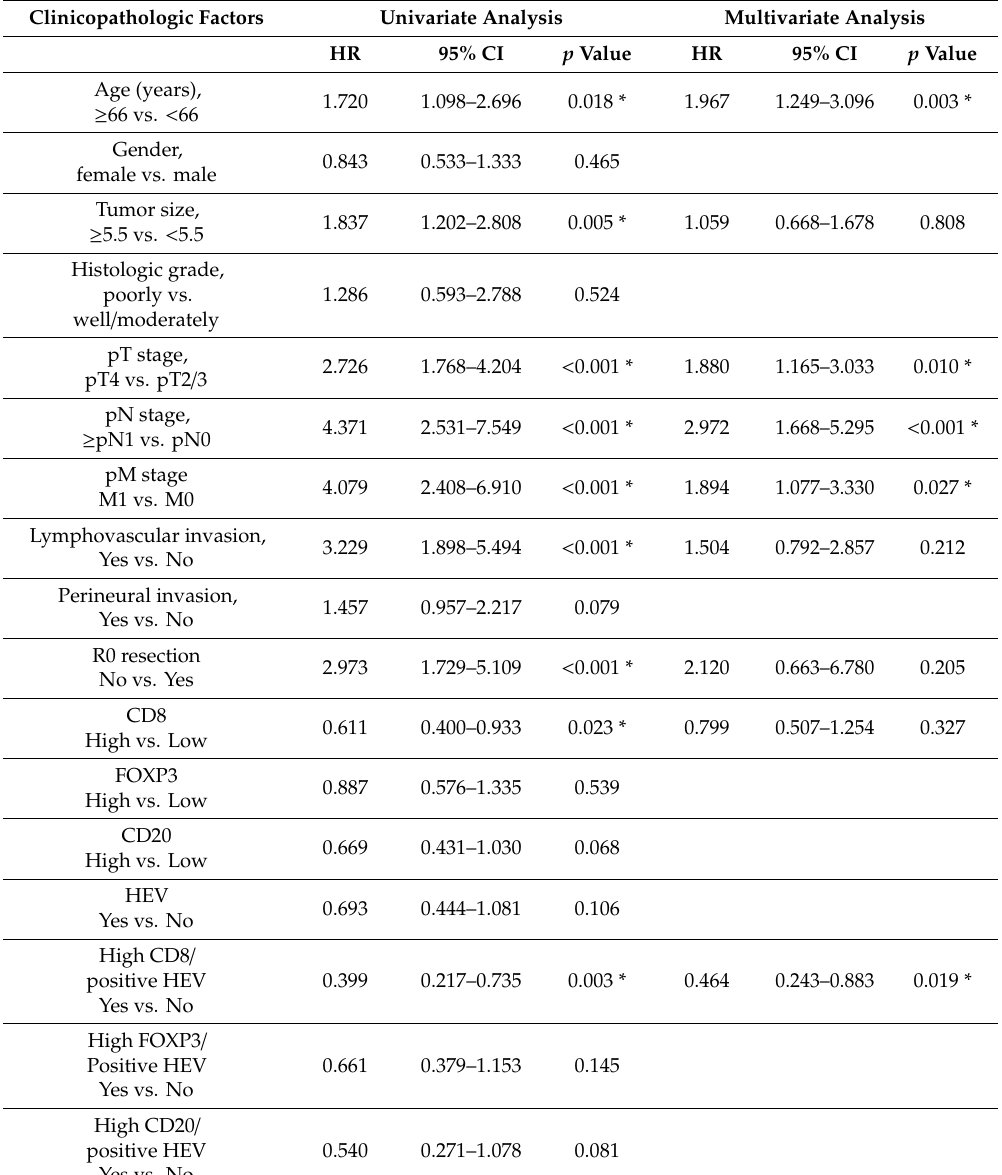
Table 3. Univariate and multivariate analyses of factors associated with overall survival of advanced gastric